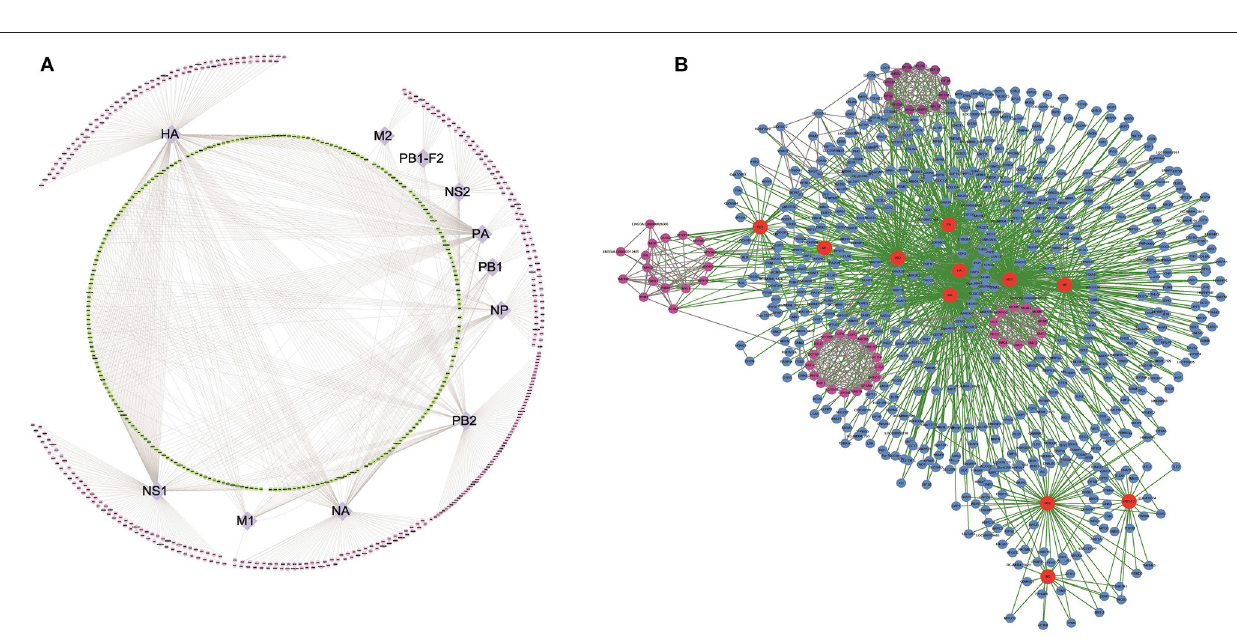
FIGURE 1 | Affinity purification of H5N1 avian influenza virus (AIV) proteins. (A) Flowchart of the proteomic affinity purification mass spectrometry (AP-MS) method used to define the H5N1 AIV–host interactome. (B) The number of host proteins identified by AP-MS that interact with individual H5N1 avian influenza virus proteins.